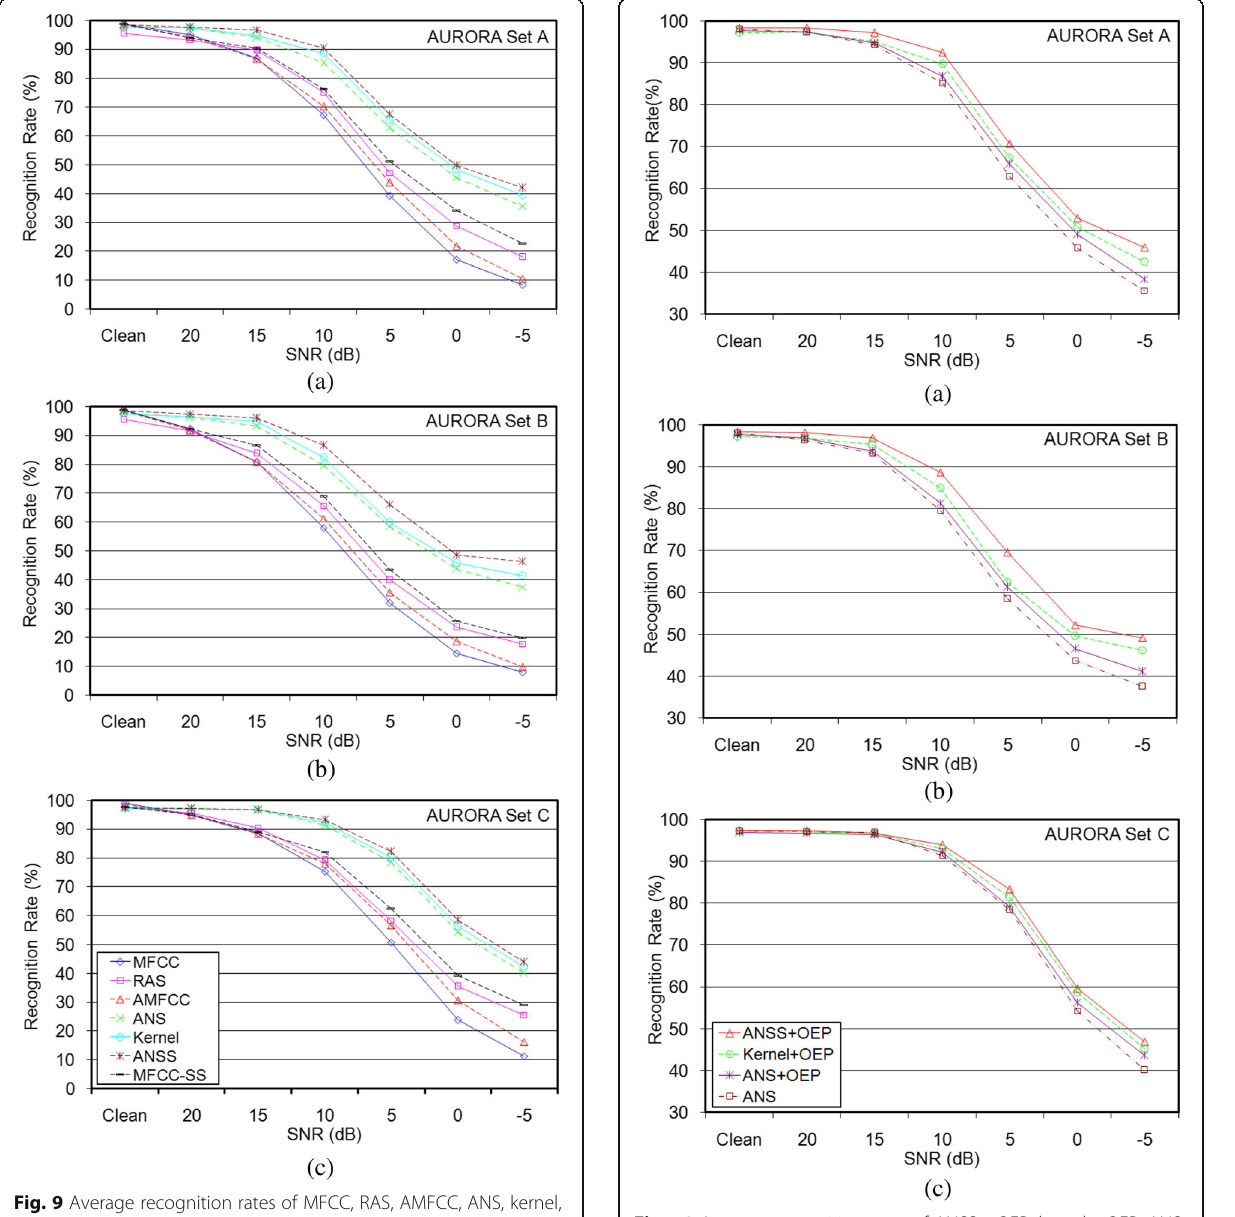
Fig. 10 Average recognition rates of ANSS + OEP, kernel + OEP, ANS + OEP, and ANS approaches on Aurora 2. a Test set A. b Test set B. c Test set